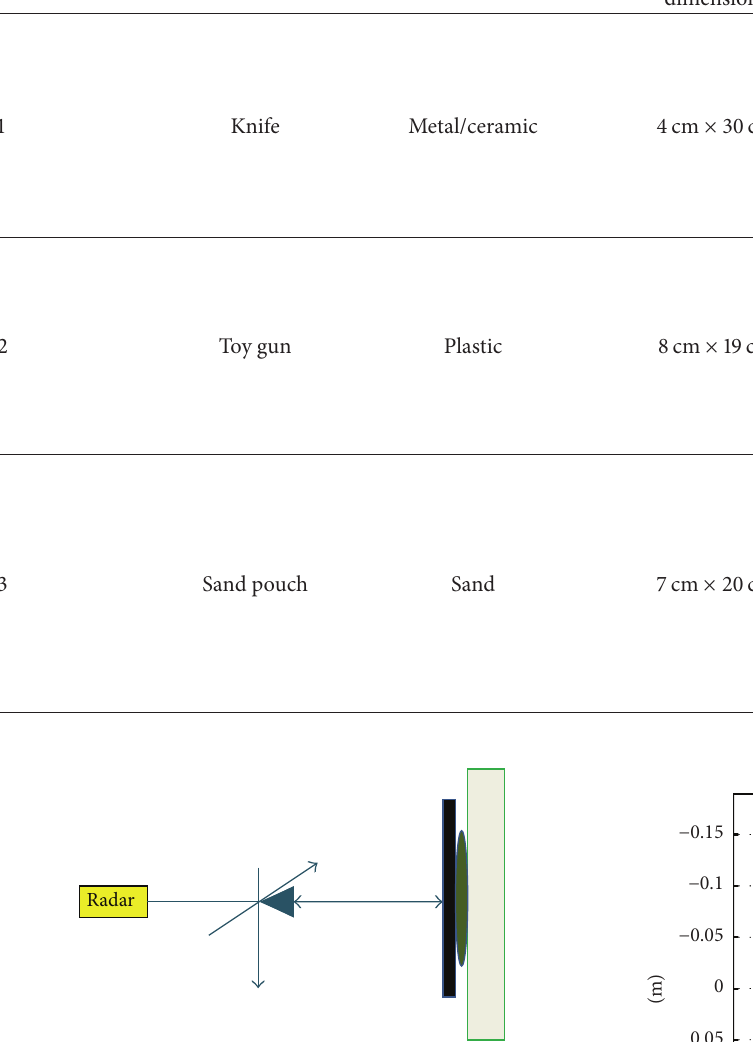
Figure 6: Configuration of the measurement (object is maintained between the coat and the absorber).